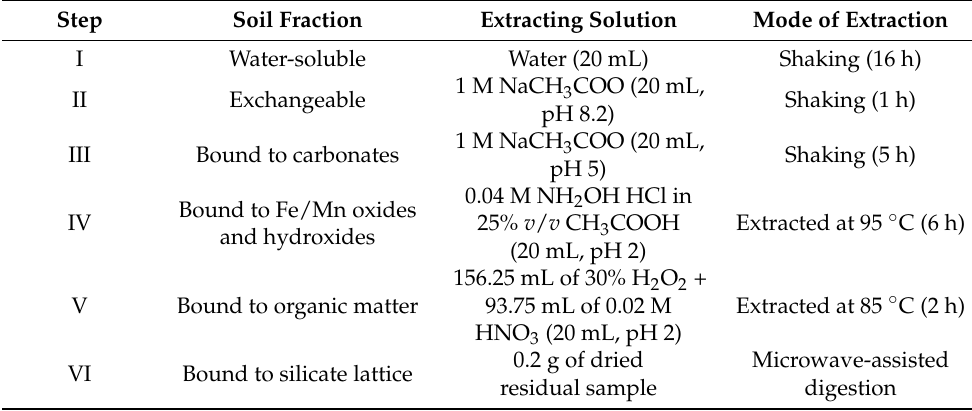
Table 1. The extraction procedure [25] used in the present